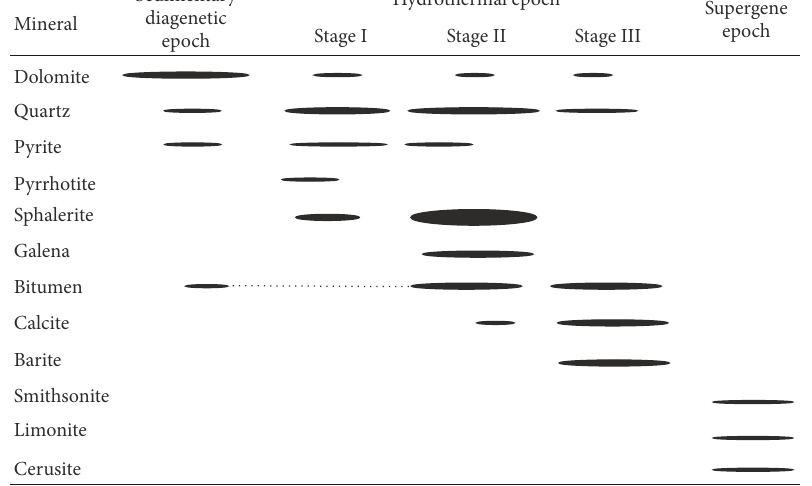
Figure 5: Paragenetic sequence for minerals in the Nanmushu Zn-Pb deposit. Stage II is the main economic stage with abundant sphalerite and